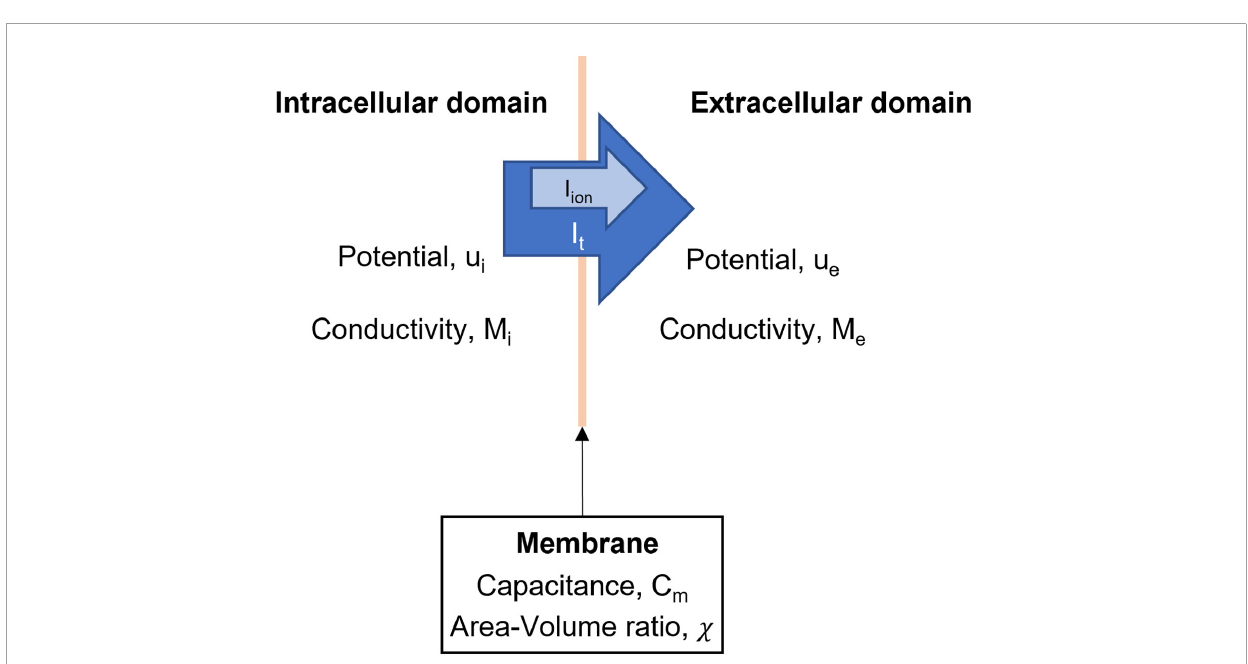
FIGURE2 Domains and variables in the bidomain model. The intracellular and extracellular domains are linked by a series of ionic currents, which give rise to changes in membrane potentials of ICC and SMC.